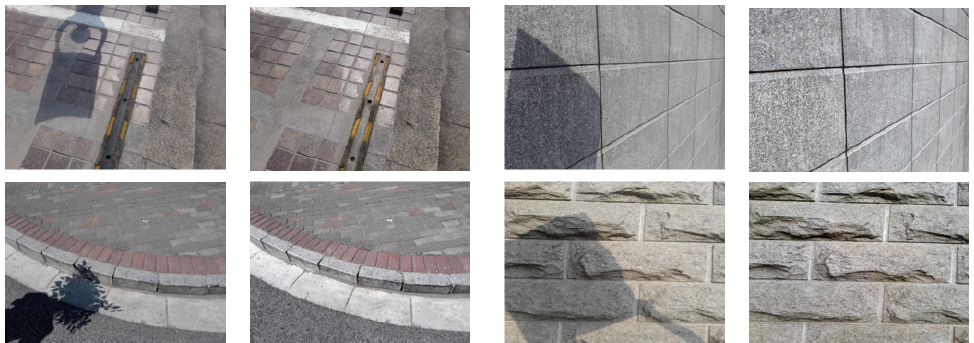
Figure 1. Some shadowed images and the corresponding results produced by our approach. The first column and the third column are the shadow images, while the second column and the fourth column are the results generated by our method. Our predicted images are natural, in which the corresponding lit region of each shadow region is more similar to its surroundings.